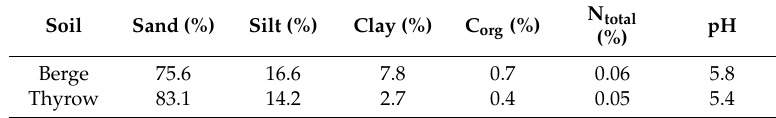
Table 4. Soil texture and chemical properties of the soils used in the soil respiration